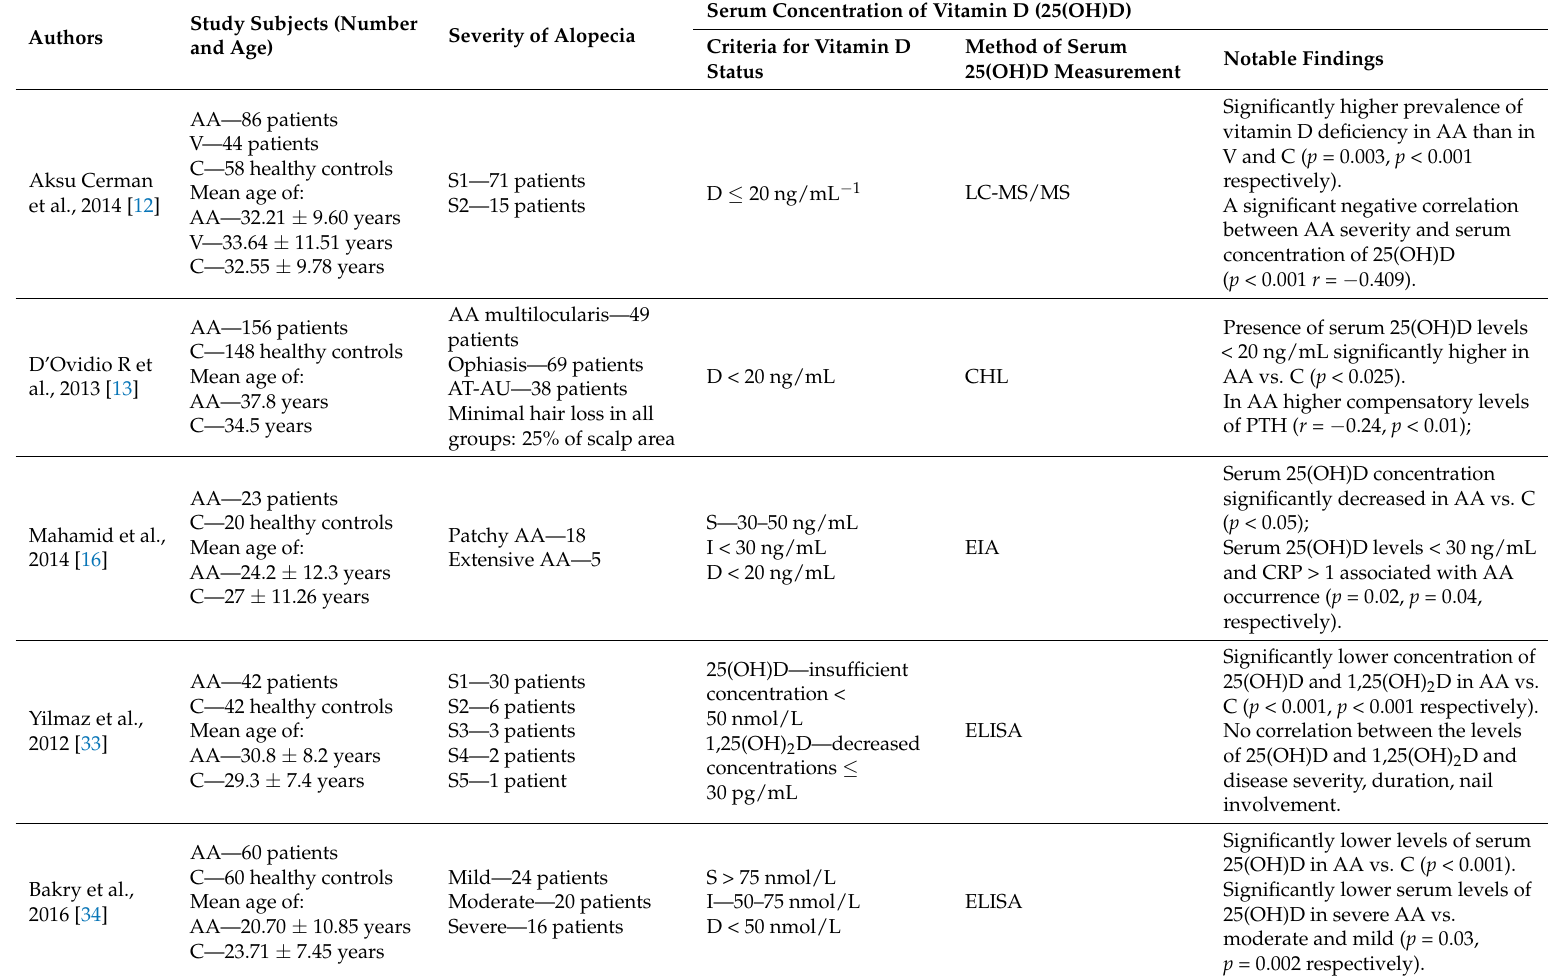
Table 1. Clinical studies evaluating serum concentration of 25(OH)D in non-scarring